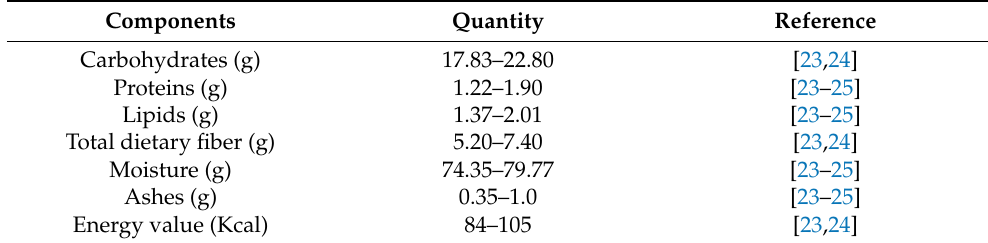
Table 1. Centesimal composition of bacuri pulp ( Platonia insignis Mart.).